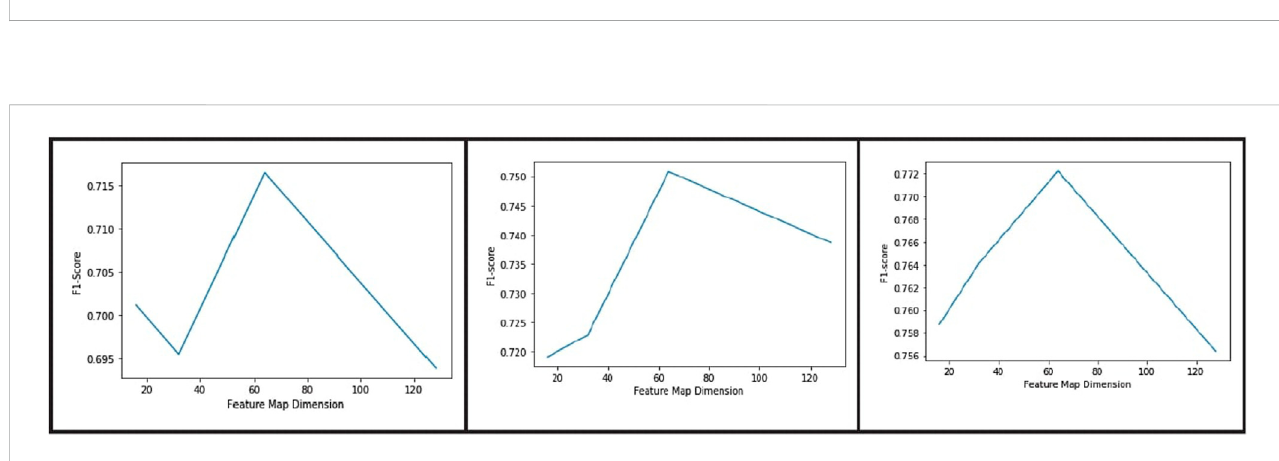
Frontiers in Signal